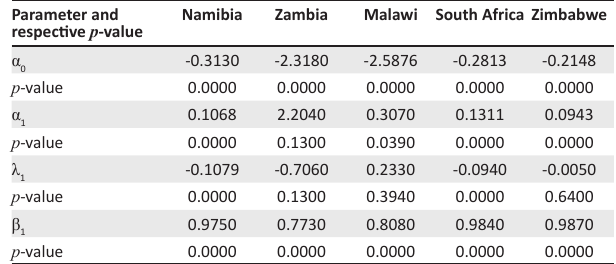
TABLE 5: Exponential generalised autoregressive conditional heteroscedasticity results assuming generalised error distribution. Parameter and Namibia Zambia Malawi South Africa Zimbabwe respective p -value